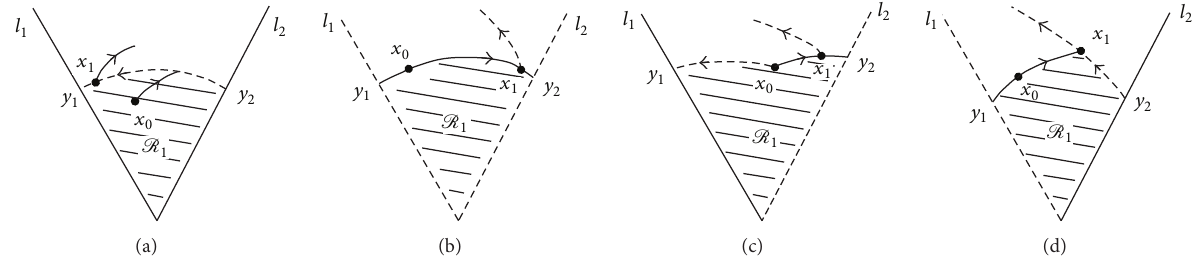
Figure 2: Figures for the proof of Theorem